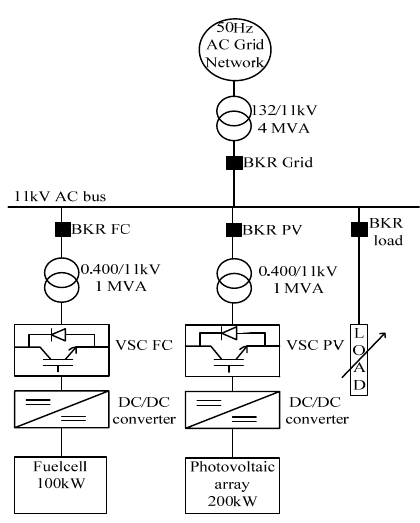
Figure 1. Grid-connected hybrid system. Figure 1. Grid ‐ connected hybrid system. Figure 1. Grid ‐ connected hybrid system.